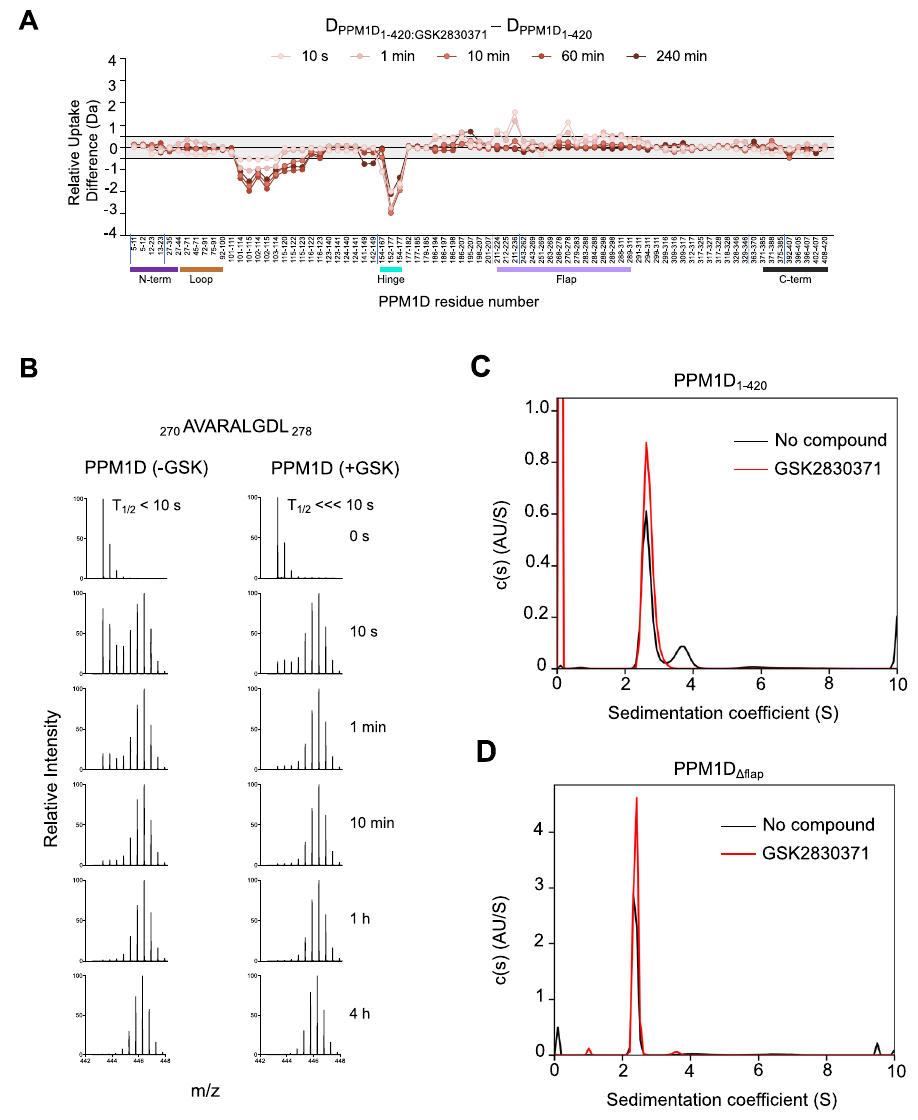
Fig. 5 GSK2830371 binding alters the conformational sampling of the fl ap domain of PPM1D. A Relative differences in deuterium uptake between PPM1D 1 – 420 in the presence of GSK2830371 compared to PPM1D 1 – 420 without GSK2830371 as assessed by HDX-MS. Vertical tick marks between peptides on the X -axis are shown to indicate regions of missing coverage. The bars below the X -axis represent the N-terminus (purple), loop (brown), hinge (cyan), fl ap (light purple), and C-terminus (black) of the protein. Reference plots are reported in Suppl. Data 1, the raw values of the plots are reported in Suppl. Data 2 B EX1 analysis showing the change in deuterium uptake for peptide 270 AVARALGDL 278 located in the fl ap region in PPM1D 1 – 420 in the absence (left) and presence (right) of GSK2830371. C Sedimentation populations of PPM1D 1 – 420 in the absence (black) and presence (red) of GSK2830371 as measured by SV-AUC. D Sedimentation populations of PPM1D Δ fl ap in the absence (black) and presence (red) of GSK2830371 as measured by